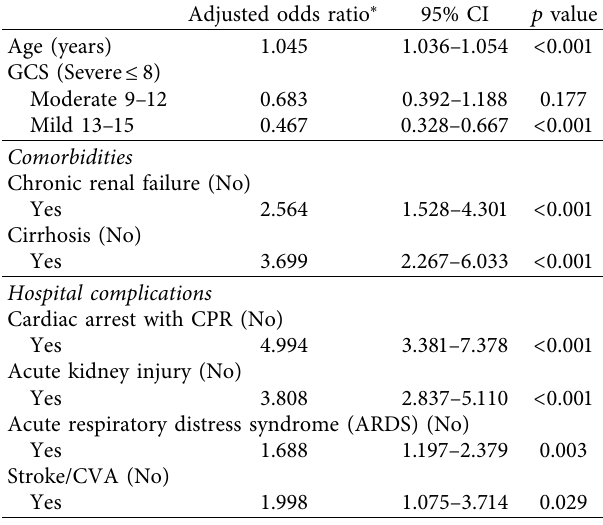
Table 6: Table showing the risk factors for mortality in trauma patients who developed sepsis during their hospital